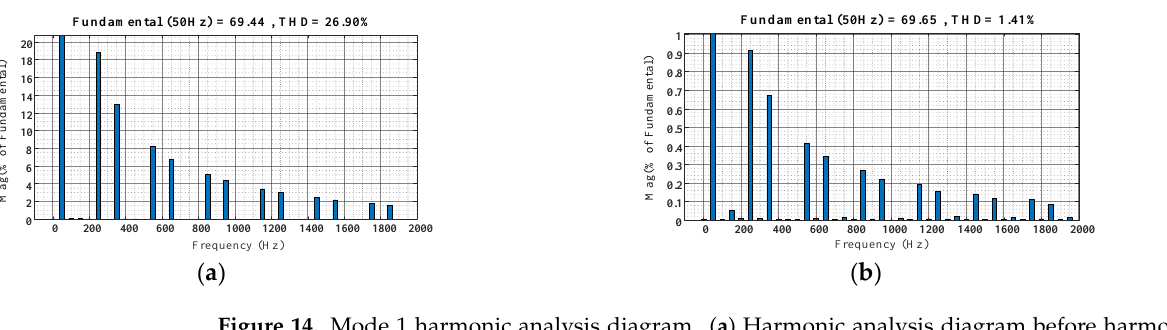
Figure 14. Mode 1 harmonic analysis diagram. ( a ) Harmonic analysis diagram before harmonic treatment. ( b ) Harmonic analysis diagram after harmonic treatment.